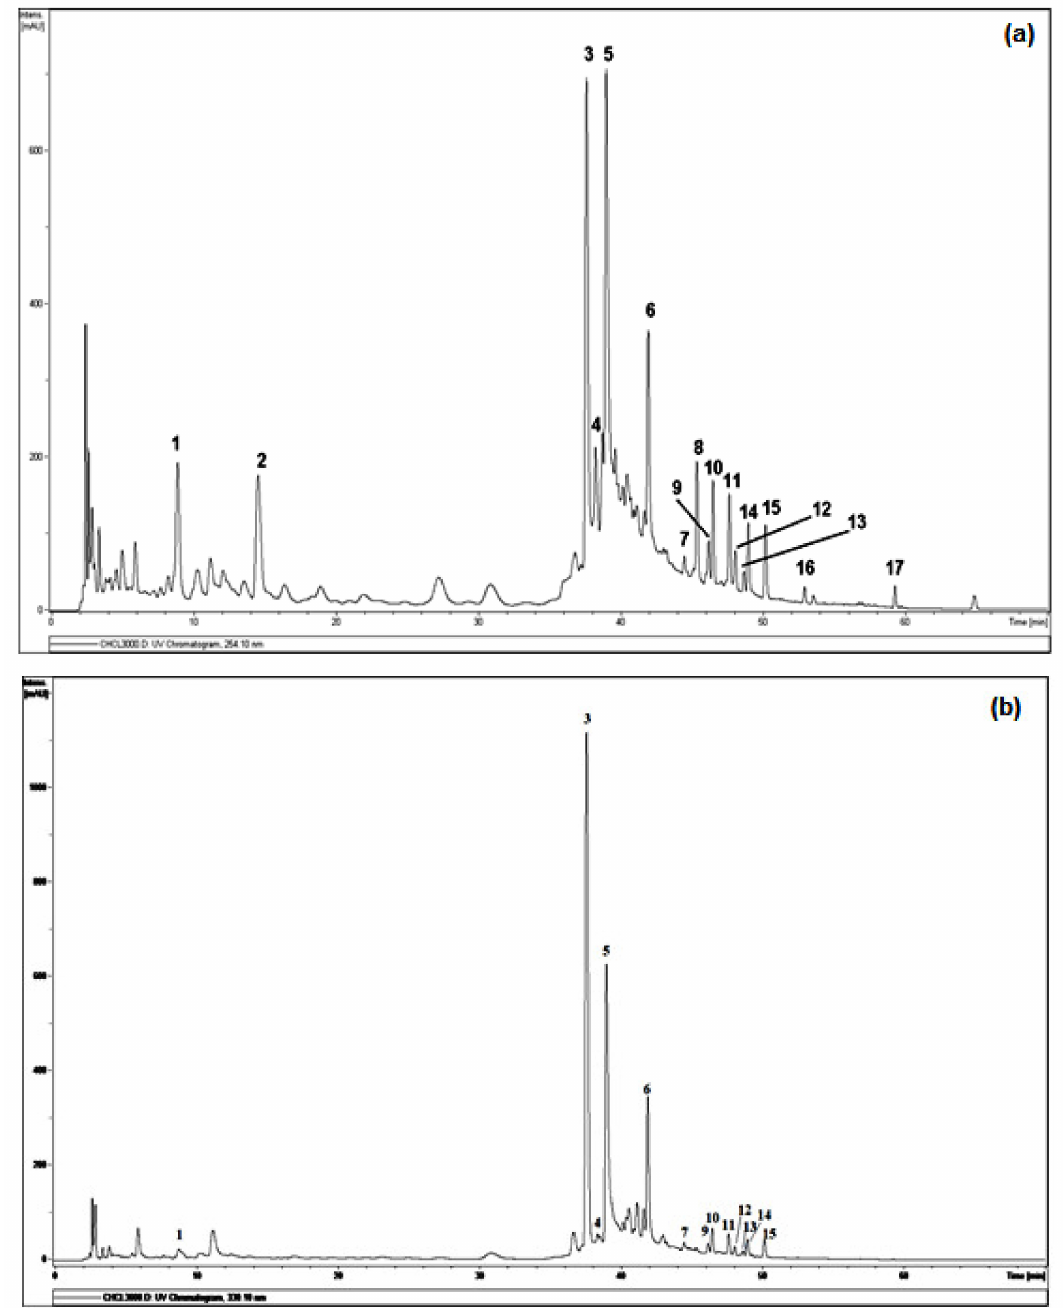
Figure 1. DAD-HPLC profile detected at 254 nm ( a ) and 330 nm ( b ) of LC–MS analysis on CHE. Legends: ( 1 ): Apigenin-7- O -glucoside, ( 3 ): Tamgermanetin, ( 5 ): Luteolin, ( 6 ): Apigenin, ( 7 ): Ramosin, ( 8 ): Aloe-emodin, ( 10 ): ( P ,10 (cid:48) S )-oxanthrone-10 (cid:48) - β -glucopyranosyl asphodelin, ( 12 ): ( M ,10 (cid:48) S )-oxanthrone-10 (cid:48) - β -glucopyranosyl asphodelin, ( 13 ): (10 (cid:48) R )-oxanthrone-10 (cid:48) - β -D- xylopyranoside asphodelin, ( 14 ): (10 (cid:48) S )-oxanthrone-10 (cid:48) - β -D-xylopyranoside asphodelin, ( 15 ): (10 (cid:48) S )-oxanthrone-10 (cid:48) - β -L- arabinopyranoside asphodelin, ( 17 ): Asphodeline. Peaks 2 , 4 , 9 , 11 and 16 are still